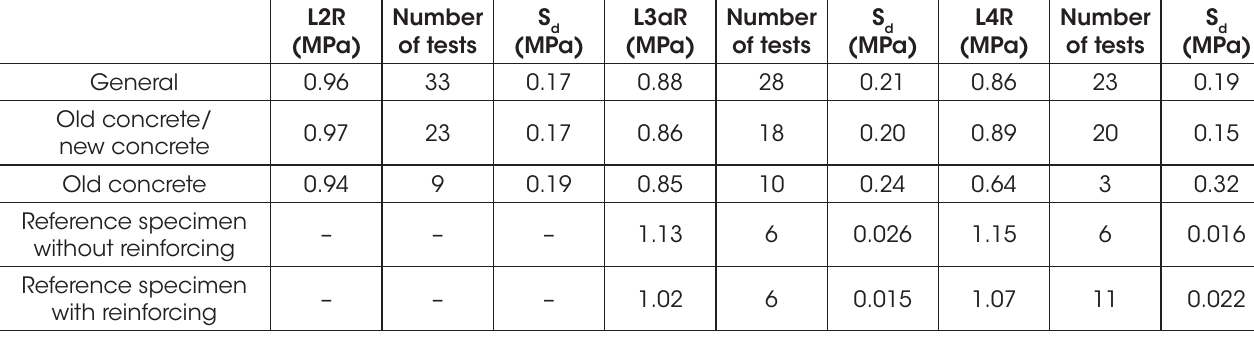
Results of pull-off tests in slabs and specimens of